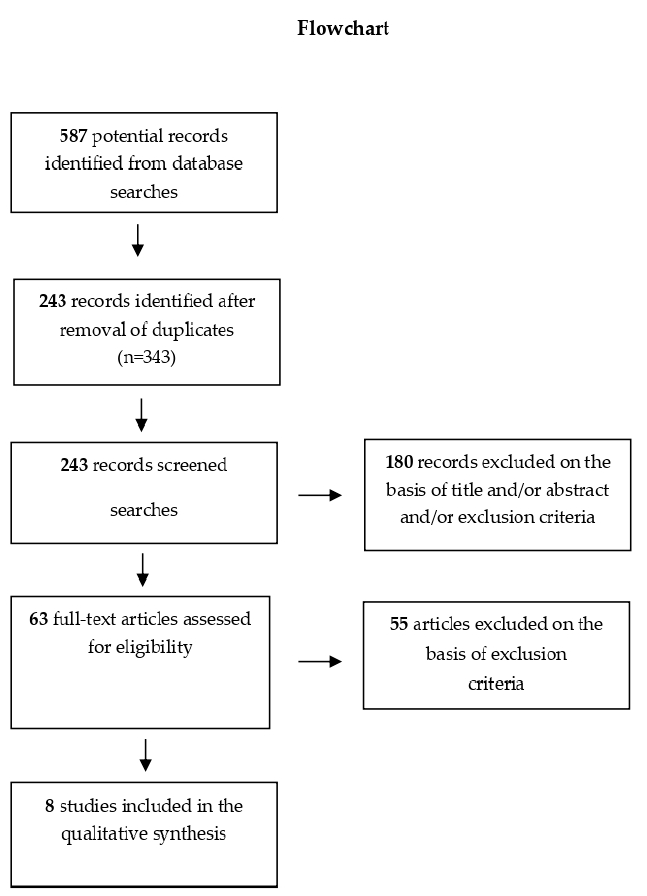
Figure 2. Flowchart illustrating the search and selection strategy used to identify the included arti ‐ cles.